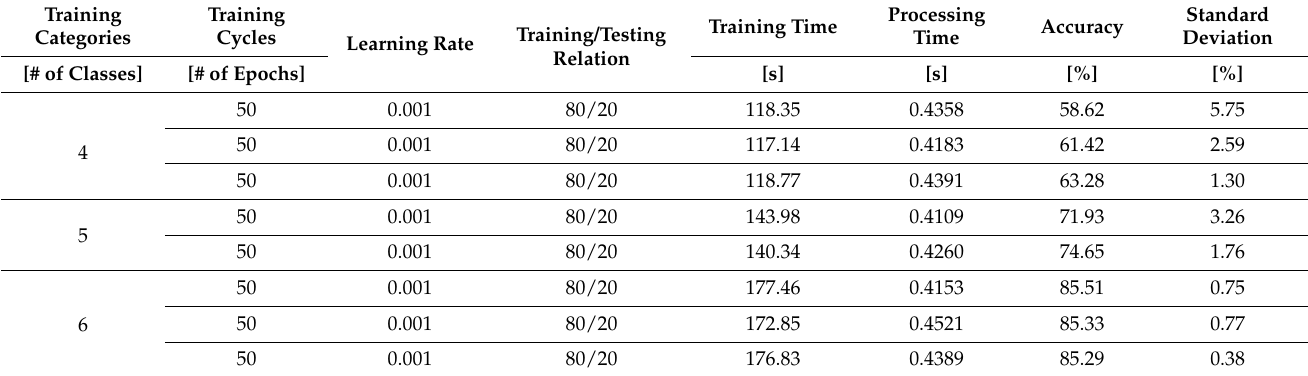
Table 6. 1D-CNN performance using different number of classes.